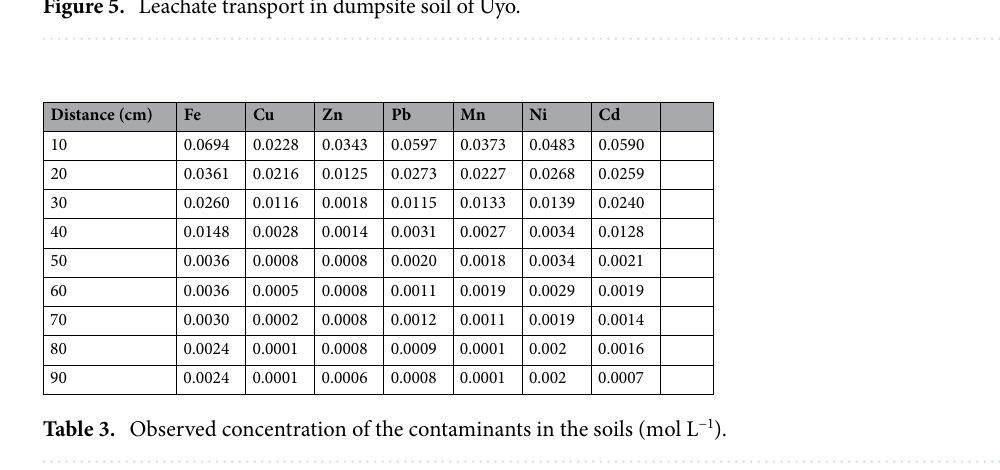
Figure 5. Leachate transport in dumpsite soil of Uyo.